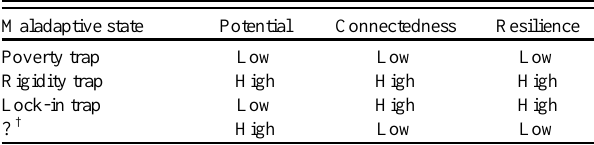
Table 2 . The level of each of the three variables that characterize the four maladaptive states (Source: Allison and Hobbs